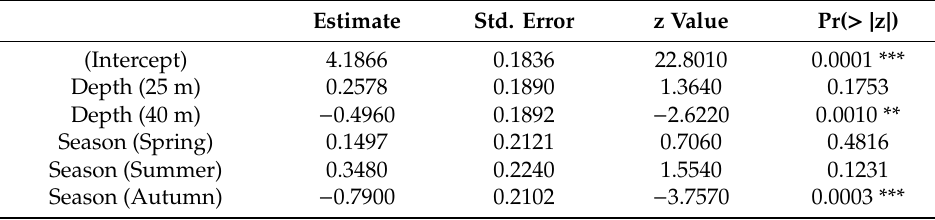
Table 4. Summary of the mixed-e ff ects GLM testing the e ff ects of the fixed factors “Depth” (18, 25, and 40 m) and “Season” on the mean size of Nanocassiope melanodactylus . The contribution of “Year” is not presented, as this was a random source of variation. Reference values were 18 m for “Depth” and winter for